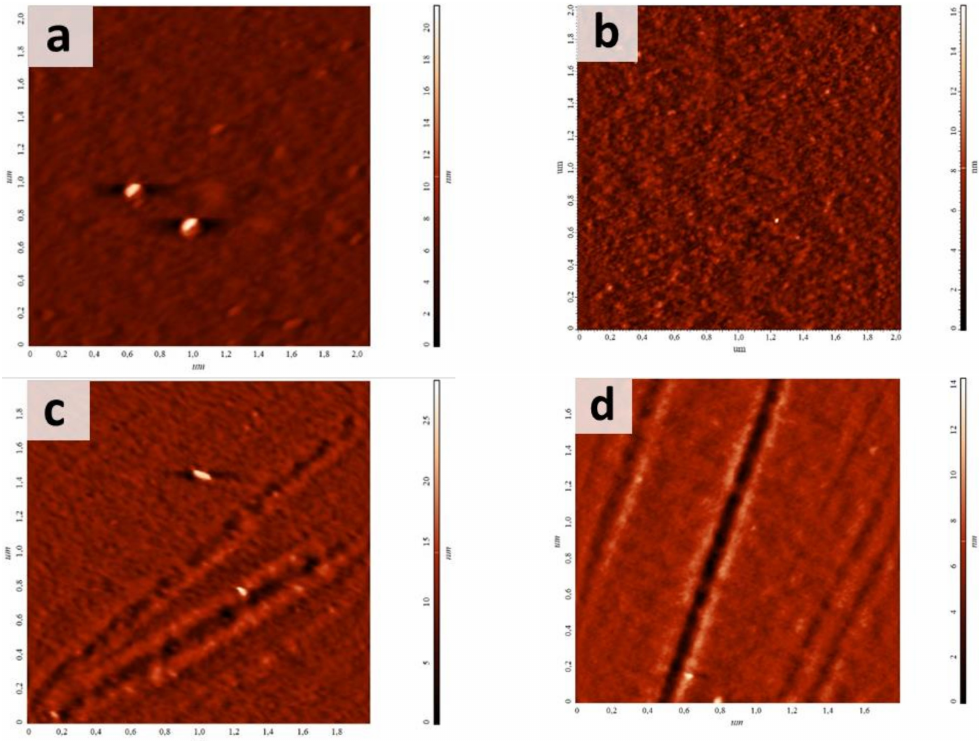
Figure 2. Atomic force microscopy (AFM) images of ( a ) initial and plasma-treated PET films using ( b ) AC- and DC-discharge ( c ) at the cathode and ( d ) at the anode.